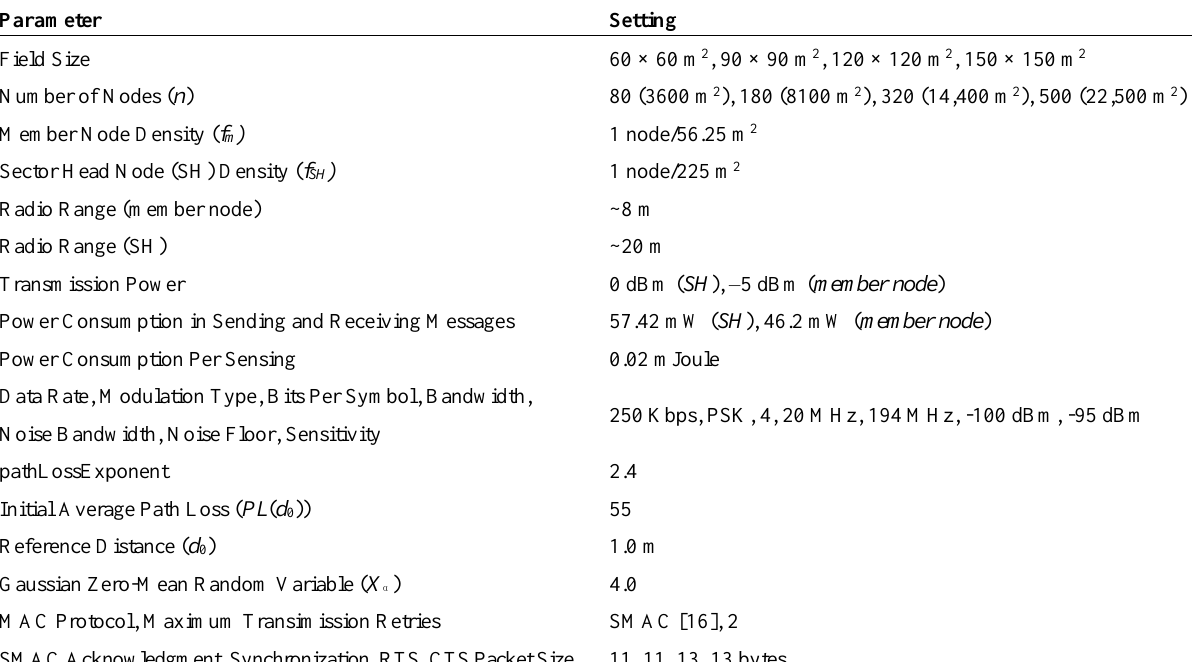
Table 6. Simulation